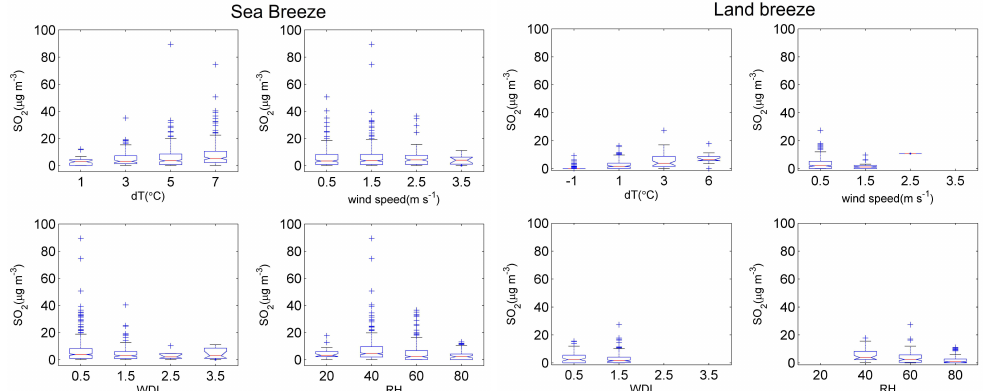
Figure 3. The same as in Figure 2, but from July to September 2007–2009.